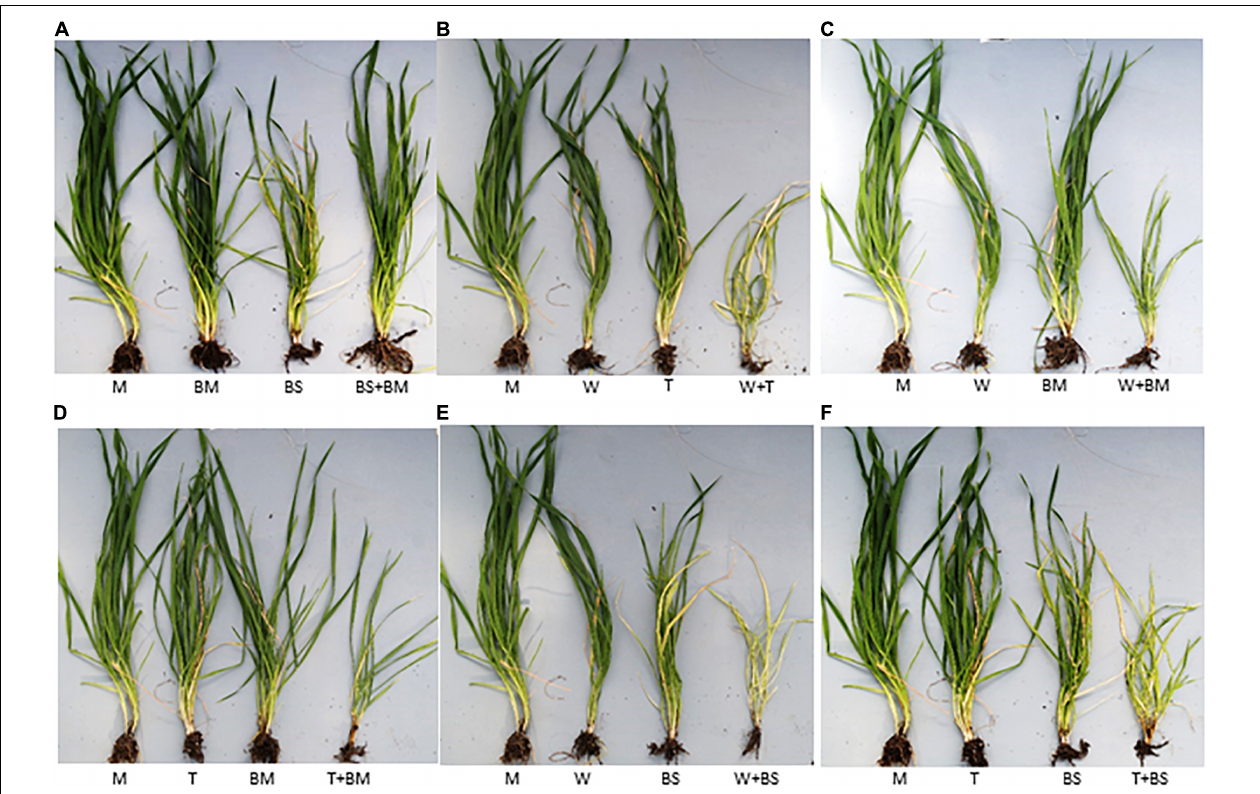
FIGURE 2 | The phenotypic effect of single and double infections of BMV, BSMV, WSMV, and TriMV on wheat cv. Arapahoe at 30 dpi. Phenotypic effects of singly and doubly infected wheat cv. Arapahoe by BMV and BSMV (A) , WSMV and TriMV (B) , WSMV and BMV (C) , TriMV and BMV (D) , WSMV and BSMV (E) , and TriMV and BSMV (F) at 30 dpi. M, mock-inoculation; BM, BMV; BS, BSMV; W, WSMV; T,